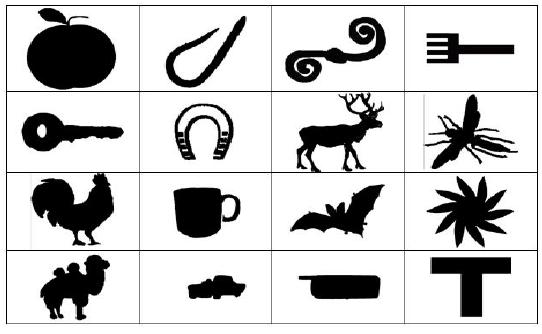
Figure 2. Example shapes taken from MPEG-7